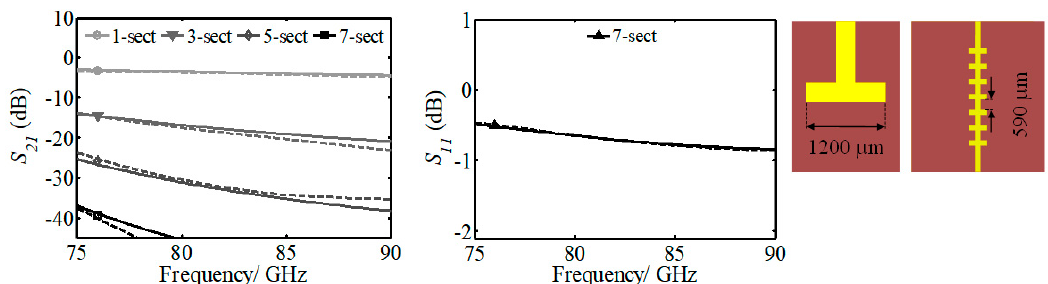
Figure 2. Left: Magnitude of isolation, | S 21 | , for a choke composed of 1, 3, 5, and 7 sections. Center: magnitude of the reflection coe ffi cient, | S 11 | , for a 7-section choke. Continuous line: calculated by a transmission line (TL) equivalent. Dashed line: simulated. Right: View of the choke.